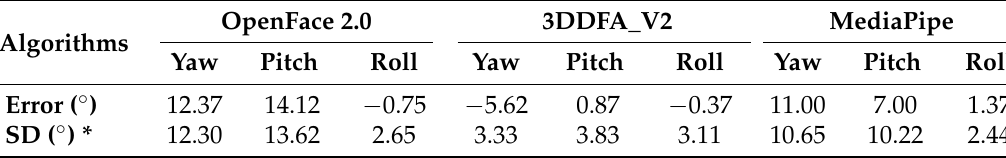
Table 2. Average errors on head pose estimation for OpenFace 2.0 and 3DDFA_V2.